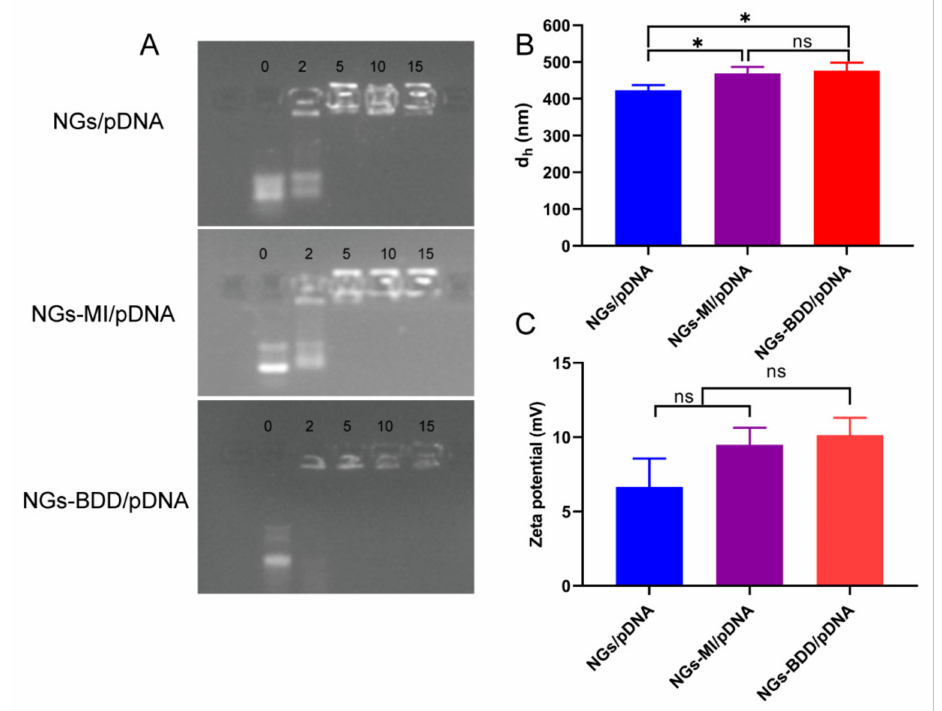
Figure 3. ( A ) Agarose gel electrophoresis of the complexes of nanogels and pDNA prepared at weight ratios ( w / w ) from 0–15, at room temperature. ( B ) Hydrodynamic diameter and ( C ) Zeta potential analysis of nanogel/pDNA complexes prepared at a weight ratio of 10, at room temperature ( n = 3, * p <